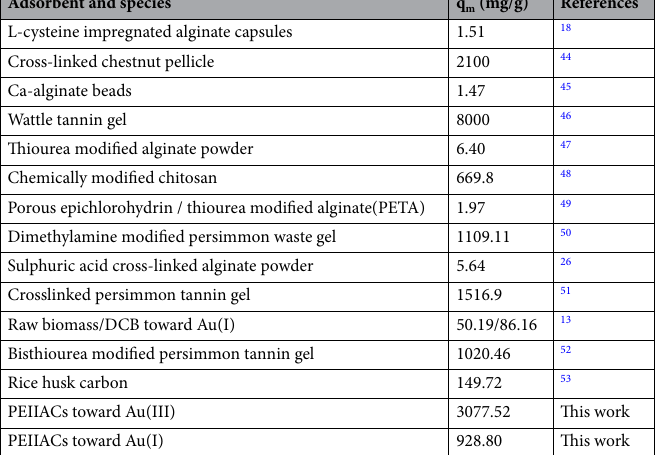
Adsorbent and species q m